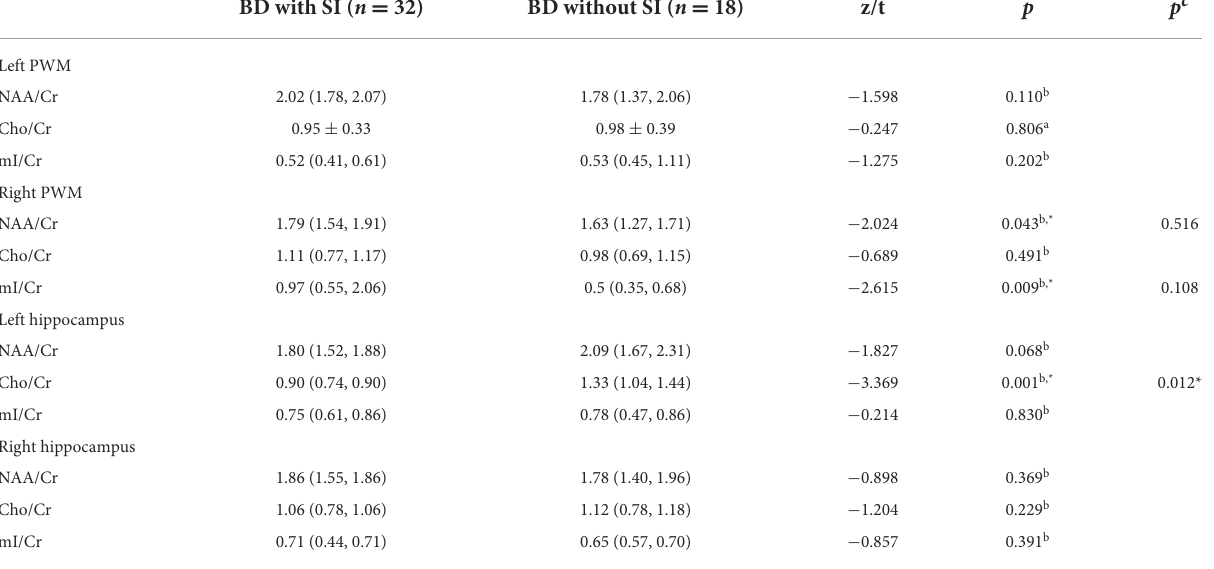
TABLE 2 Comparisons of proton magnetic resonance spectroscopy in the bilateral PWM and hippocampus of BD patients with and without SI. BD with SI ( n = 32) BD without SI ( n =